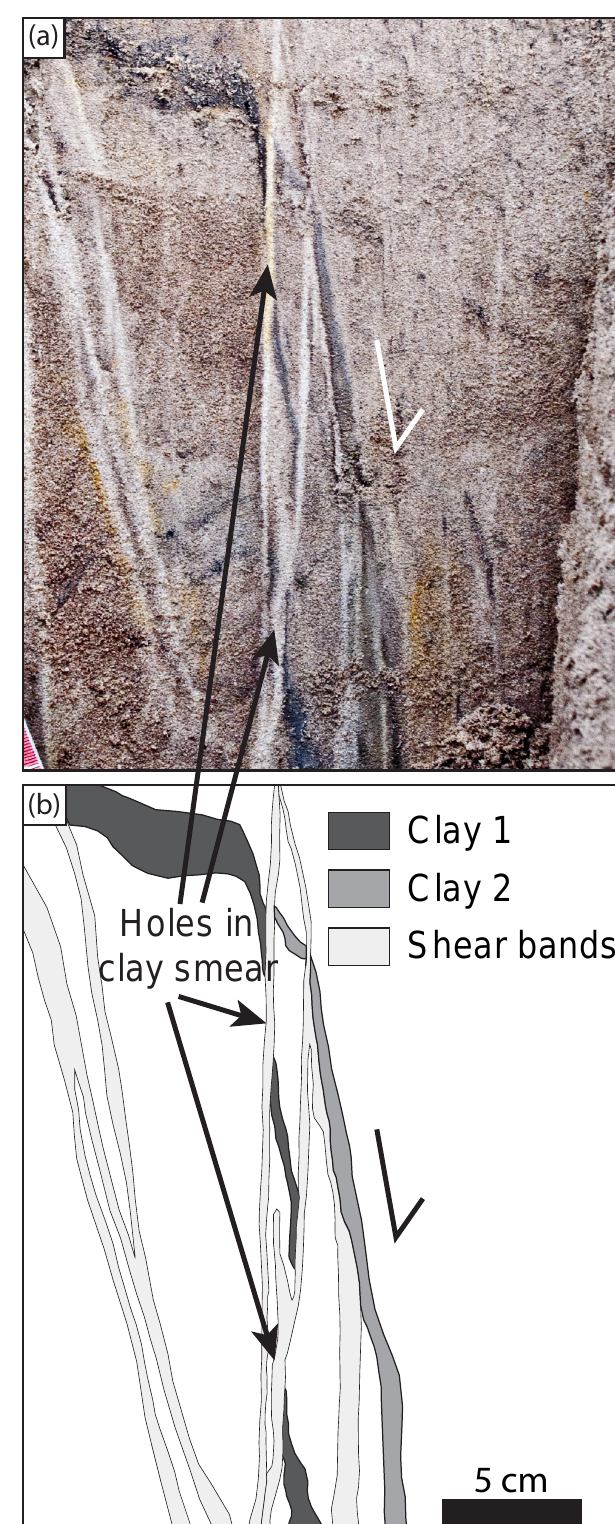
Figure 21. Hole in clay smear in a vertical section due to cross- cutting shear bands: (a) field photograph, (b) interpretation of shear bands and